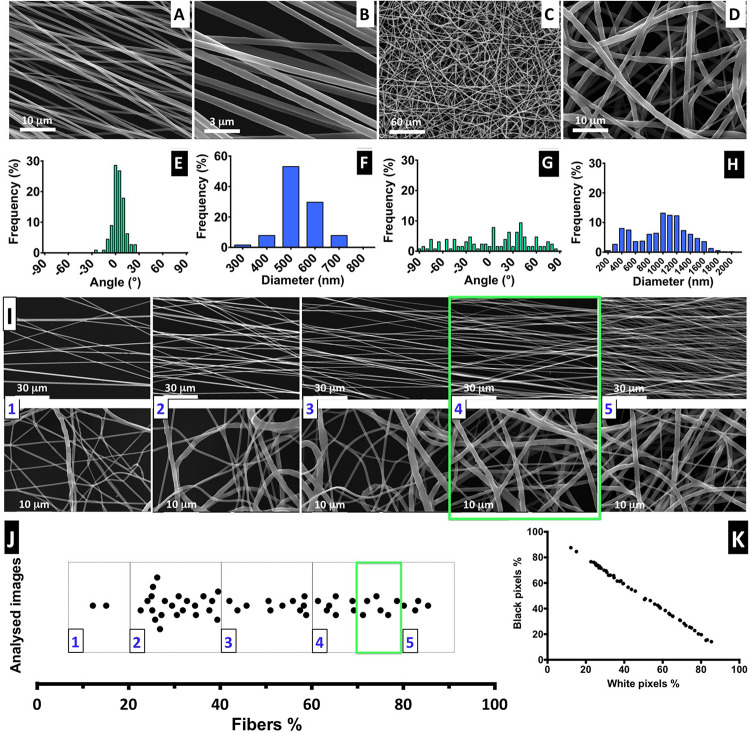
Fiber characterization: (A–D) SEM images of aligned and randomly distributed fibers (fiber density 70–80%). (E–H) Histograms of alignment profile and fiber diameter distribution. At least 100 fibers were measured in each case. (I) SEM images for aligned and random fibers, ordered from low- to high-density mesh; scale bars: 30 and 1 μm for the aligned and random meshes, respectively. (J) Distribution of analyzed images with correspondent percentage of fiber mesh, divided into five degrees of density percentage; highlighted with a green square is the interval of fiber density of the samples selected for the cell culture experiments. (K) Proportion of the black and white pixels that compose the bimodal images.